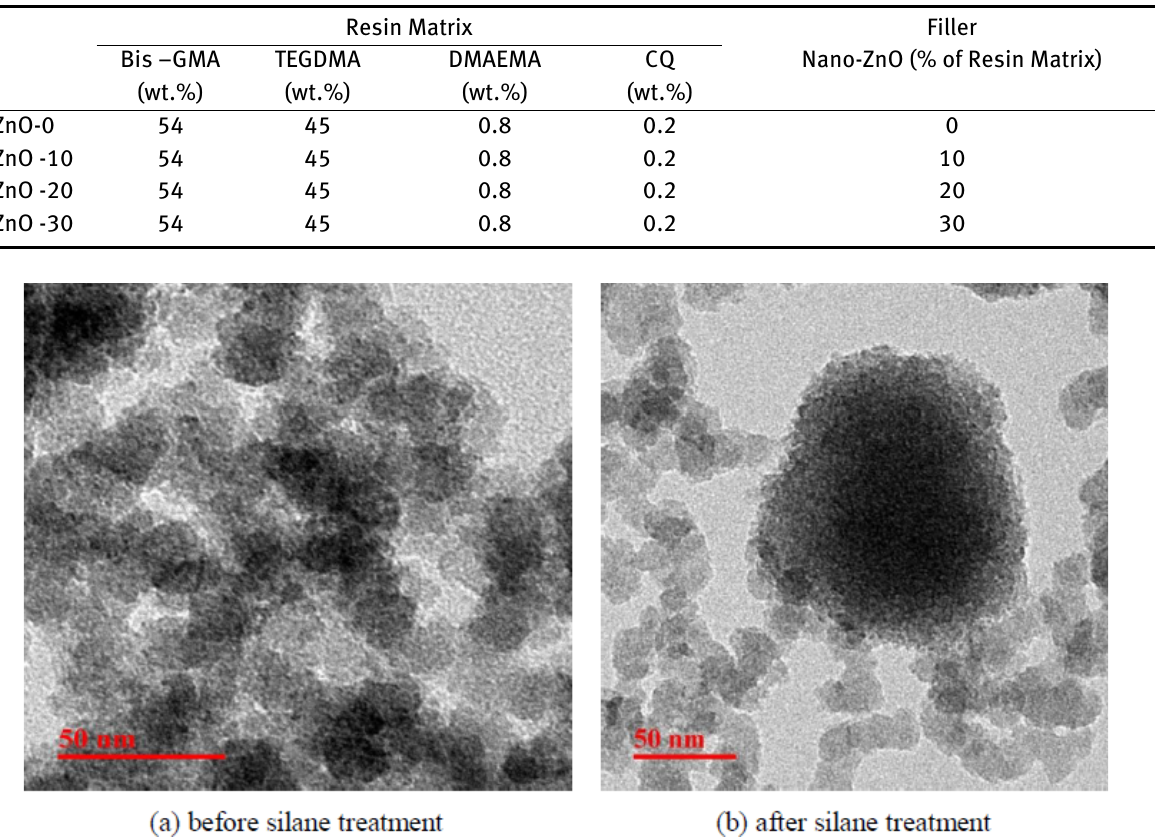
range of 25–150 ∘ C at a heating rate of 10 ∘ C/min. The cylin- drical specimen of 4 mm diameter and 6.2 mm height have been fabricated and divided into groups of three samples